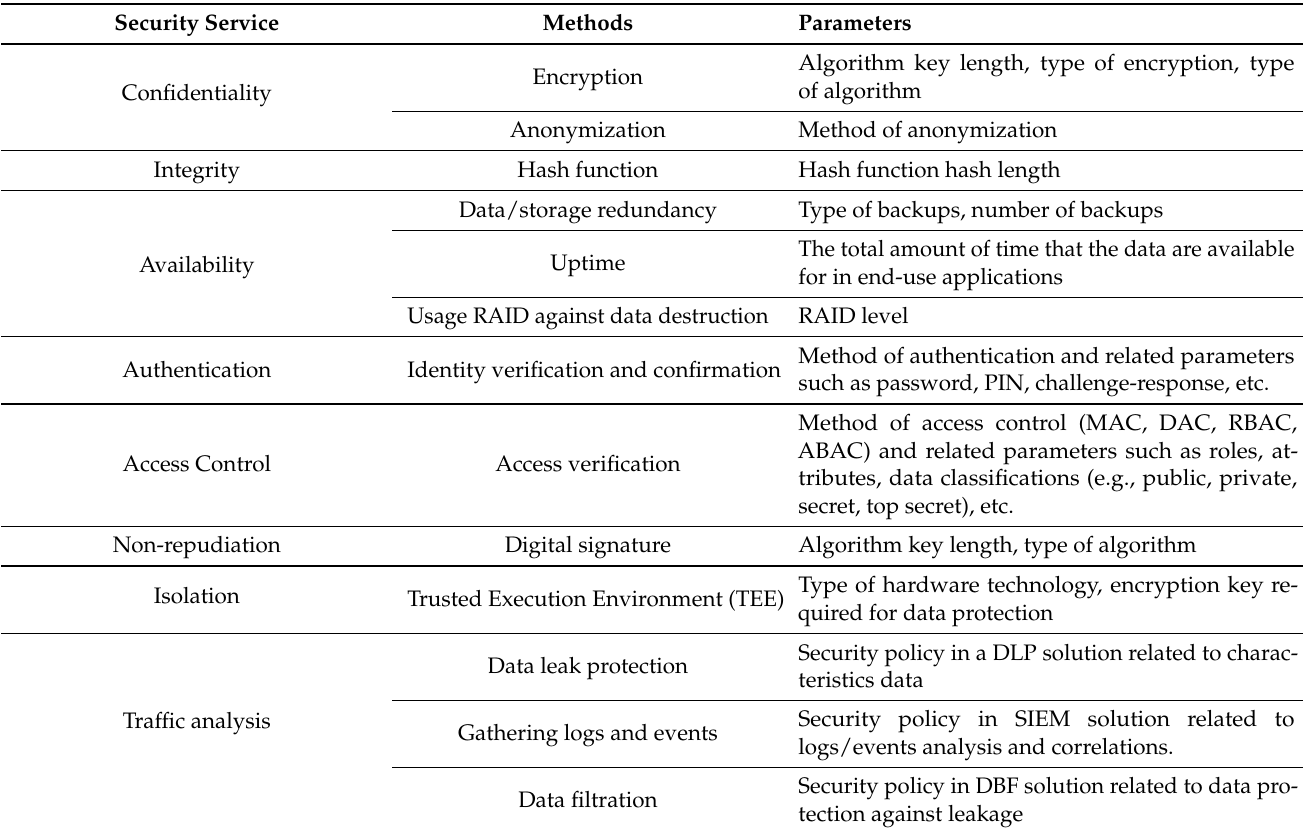
Table 1. Security context examples.